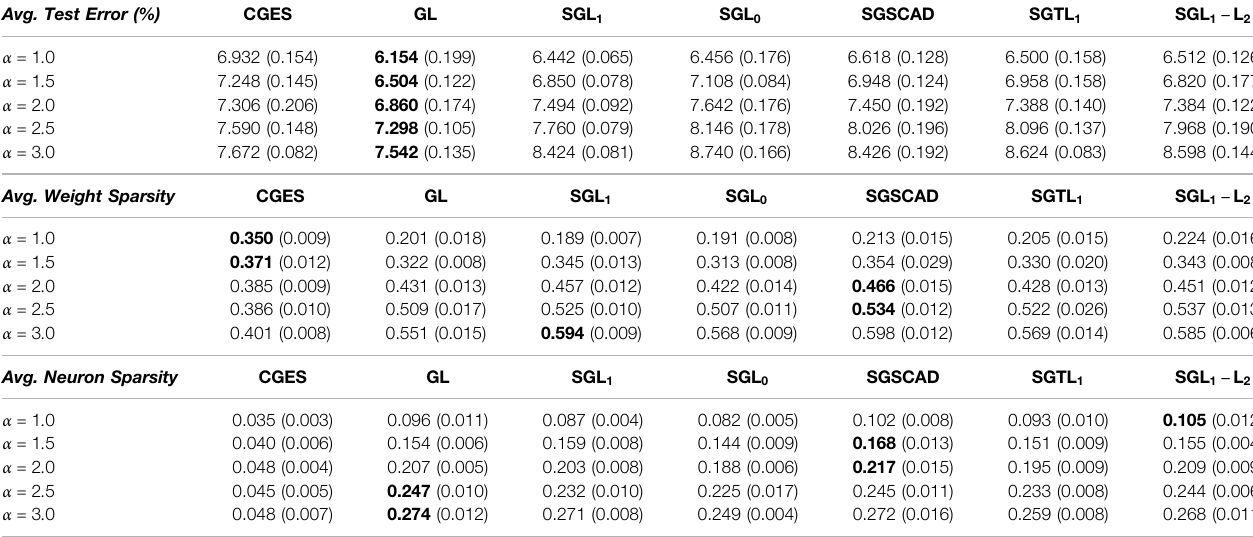
TABLE6| Averagetesterror,weightsparsity,andneuronsparsityofResnet-40modelstrainedonCIFAR10withlowesttesterrorsacross5runs.Standarddeviationsarein parentheses. Avg. Test Error (%)